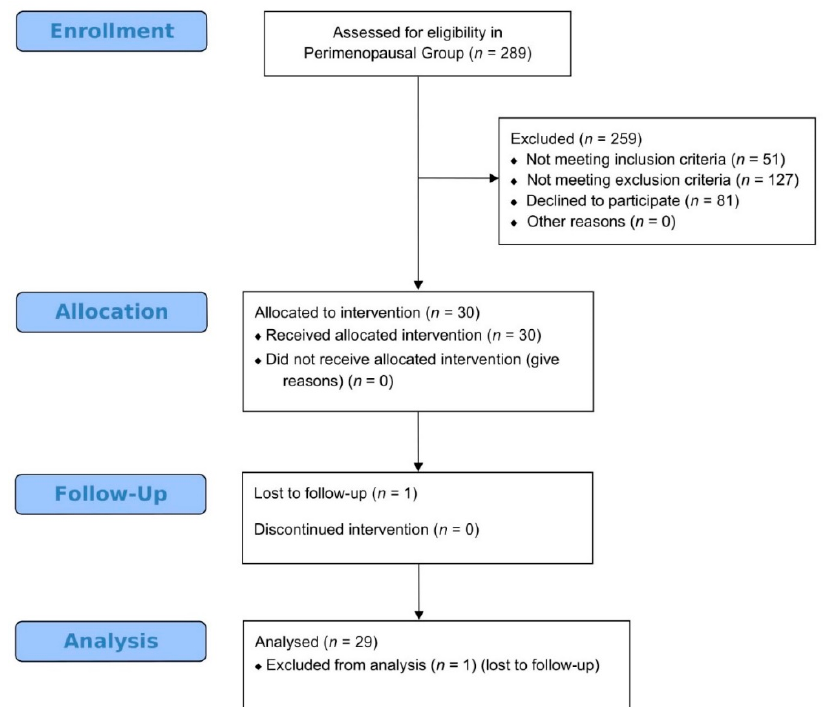
Figure 4. A modified version of CONSORT flow-chart presenting enrollment, allocation, follow-up and analysis of participants regarding the Perimenopausal pilot study.